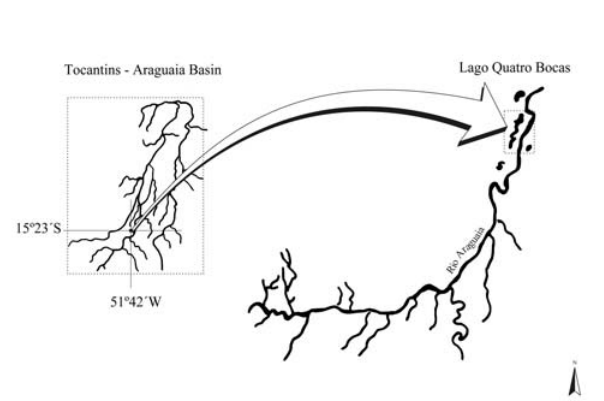
Fig. 1 . Partial map showing the Tocantins-Araguaia basin. In prominence, the rio Araguaia. Arrow indicates the lago Quatro